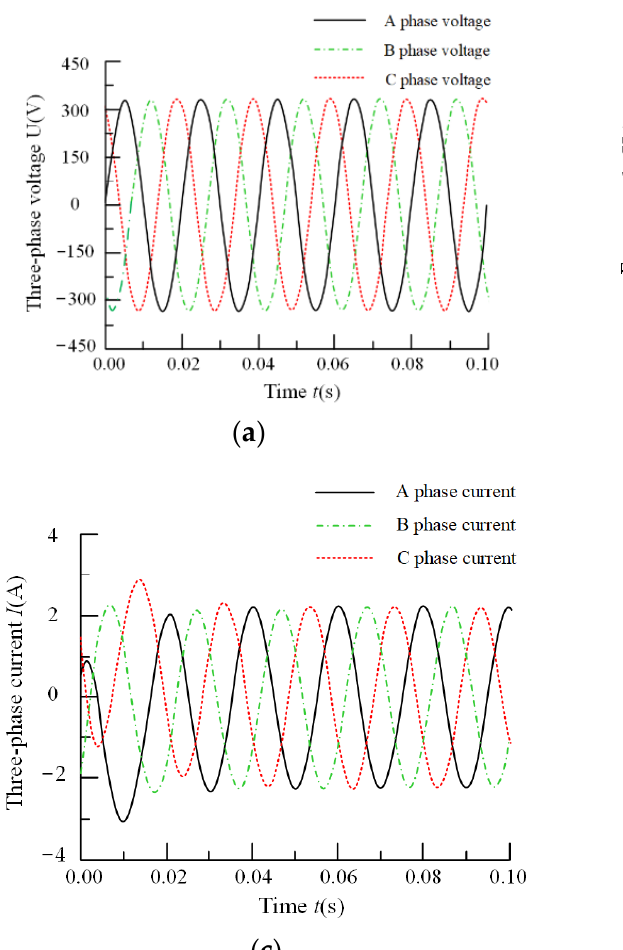
Figure 21. Hydraulic transmission system equipment drawing.